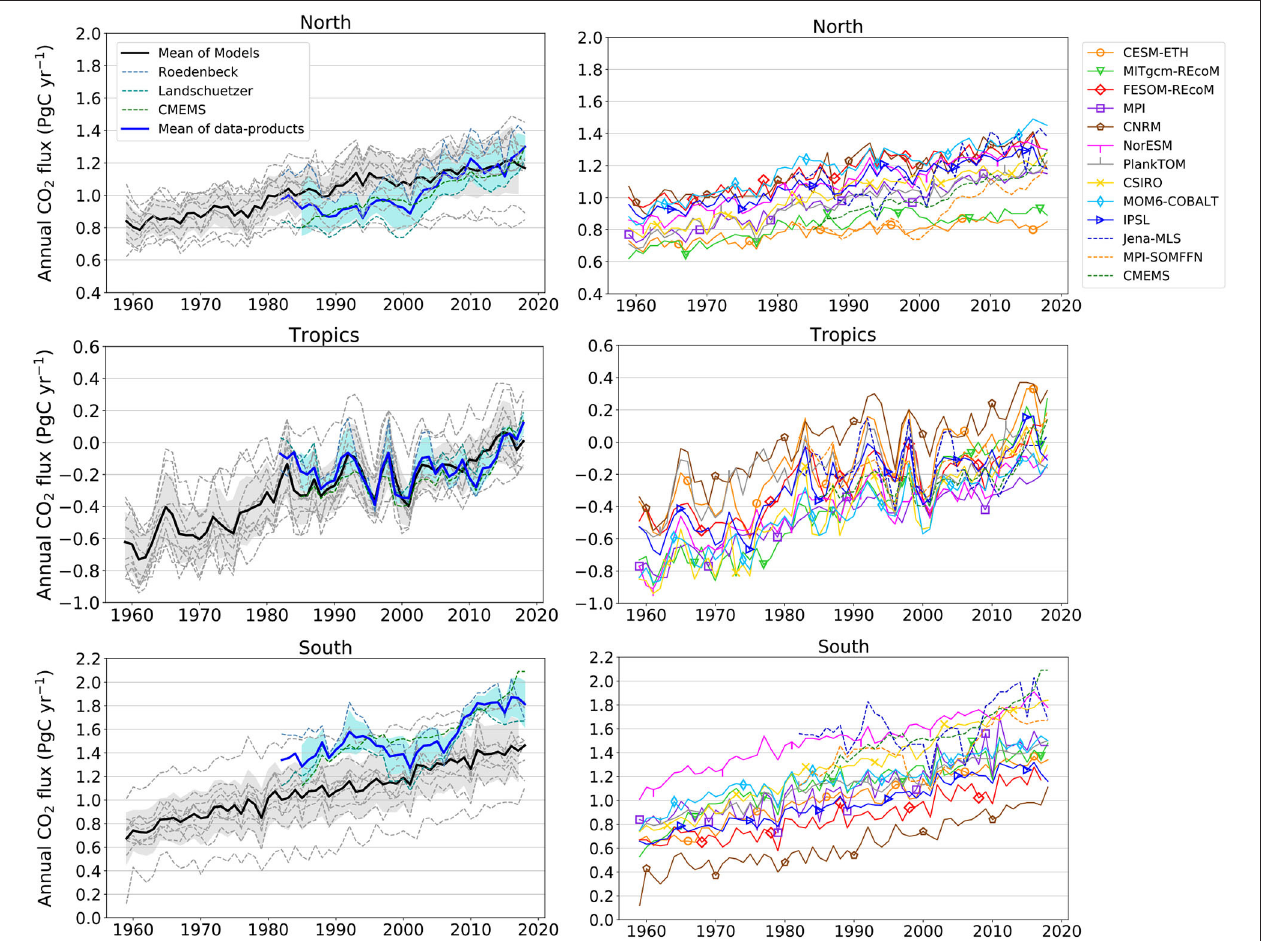
FIGURE 4 | Annual air-sea CO 2 flux integrated over the regions North (north of 30 ◦ N, top), Tropics (30 ◦ S-30 ◦ N, center), South (south of 30 ◦ S, bottom). These time-series are taken from the historical simulation A and are not corrected for biases or covered area. Note the different scales for different regions. Horizontal lines have the same distance in all subfigures (0.2 PgC yr − 1 ). Positive: CO 2 flux into the ocean. Left: Ensemble mean of Global Ocean Biogeochemical Models and data-products. Individual models in gray. Right: Individual models and data-products color